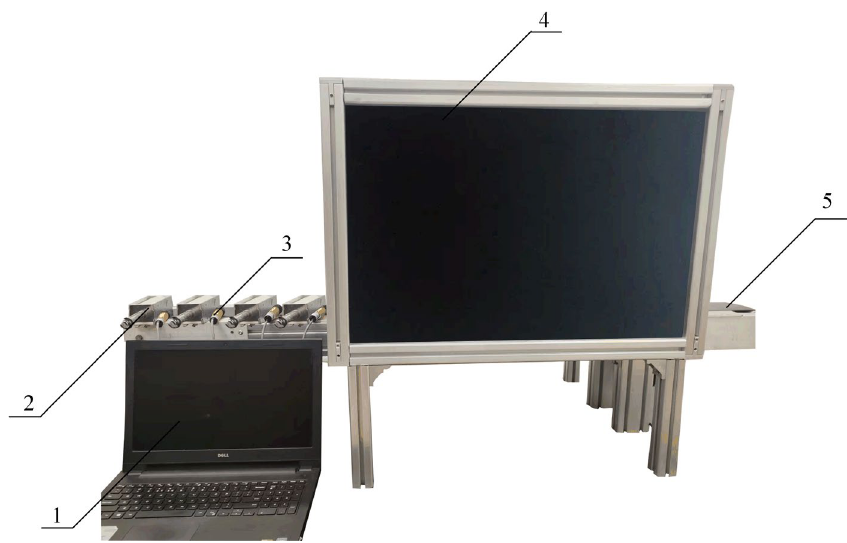
Figure 13. Experimental prototype. 1-Computer, 2-Push-pull electromagnet, 3-Photoelectric sensor, 4-Image acquisition cabin, 5-Conveyor. Table 2. Hardware parameters.